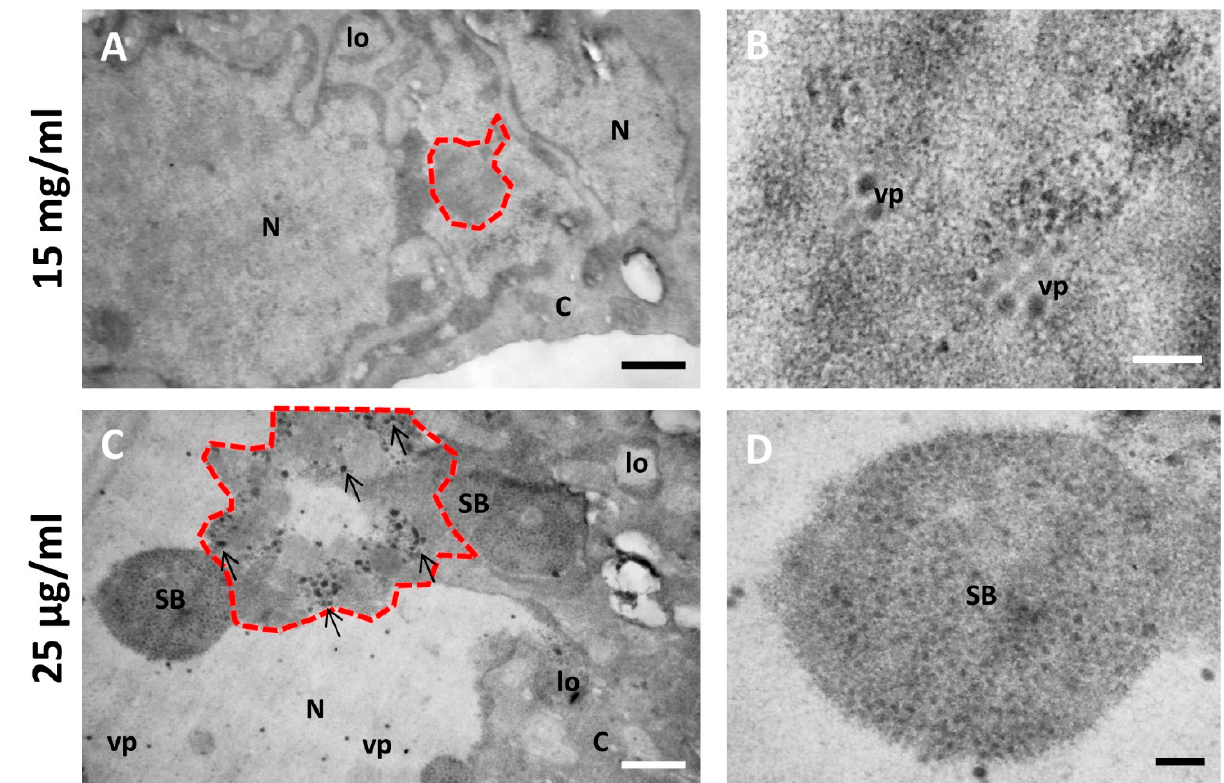
Figure 7. Effect of different BrdU concentrations on the morphology of AdV-infected cells. ( A , B ) Cells infected with Ad5/FC31 and incubated with two doses of BrdU at 15 mg/mL. ( C , D ) Cells infected with Ad5/FC31 and incubated with two doses of BrdU at 25 µg/mL. Cells collected at 48 hpi, MOI = 5 (similar structures were observed at MOI = 50). Nucleus (N), cytoplasm (C), lobes (lo), viral particles (vp), speckled body (SB), replication center (red dotted line), and electron-dense granules (arrows). Scale bars 800 nm ( A , C ) and 200 nm ( B , D ).